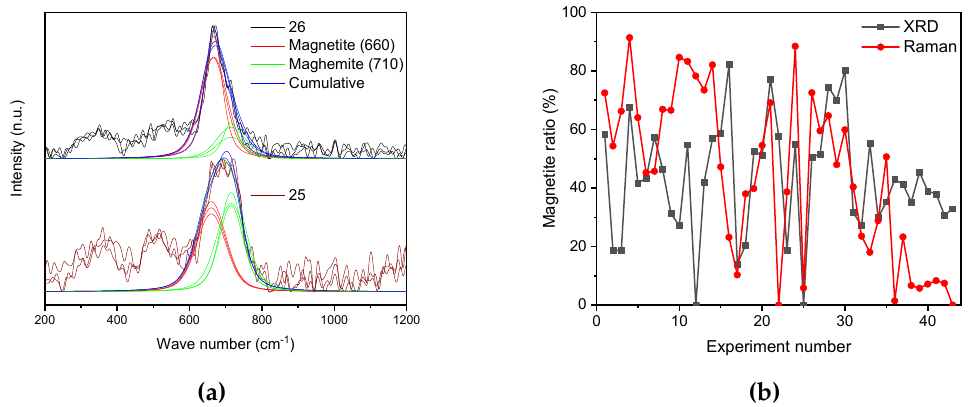
Figure 4. Raman spectra of sample 25 and 26 which illustrate the deconvolution fitting ( a ). Correlation of magnetite ratios obtained from Raman spectroscopy (Ratio between 660 and 710 cm − 1 band) and XRD (440 reflection) for all samples according to their number in the design of experiments (b) .